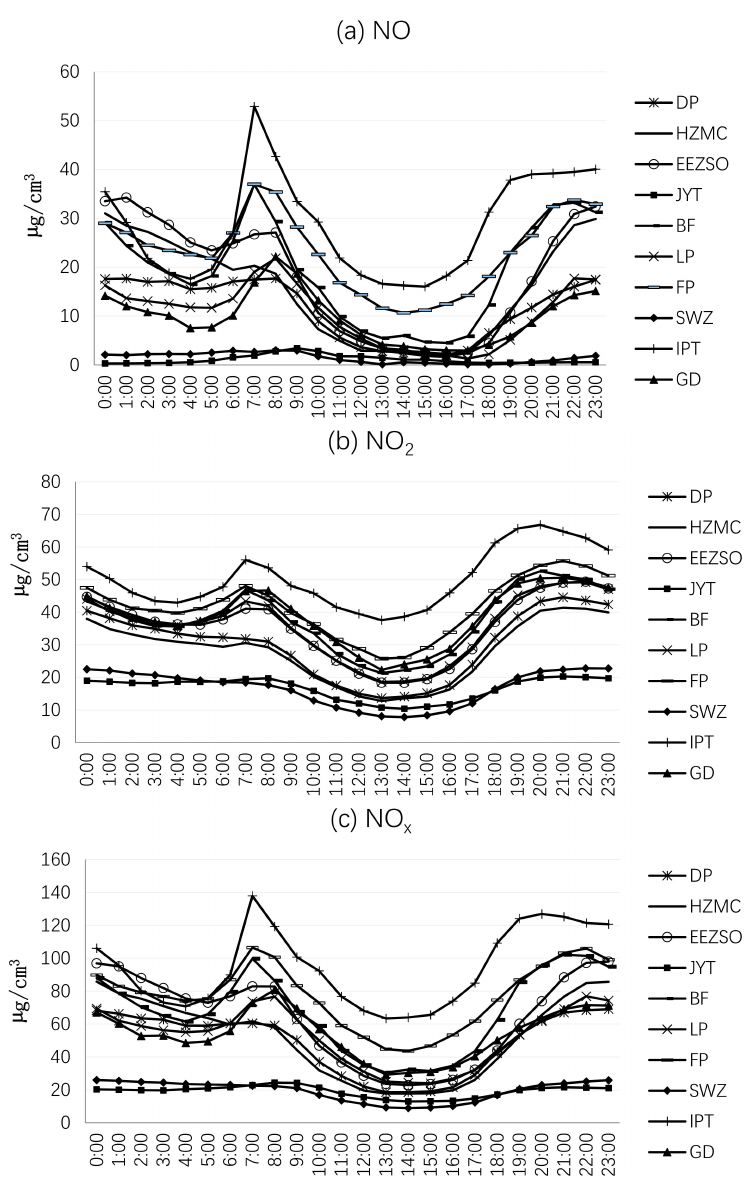
Figure 4. Daily average concentration of nitrogen compounds at each station in Changchun, 2018: ( a ) NO, ( b ) NO 2 , ( c ) NO x